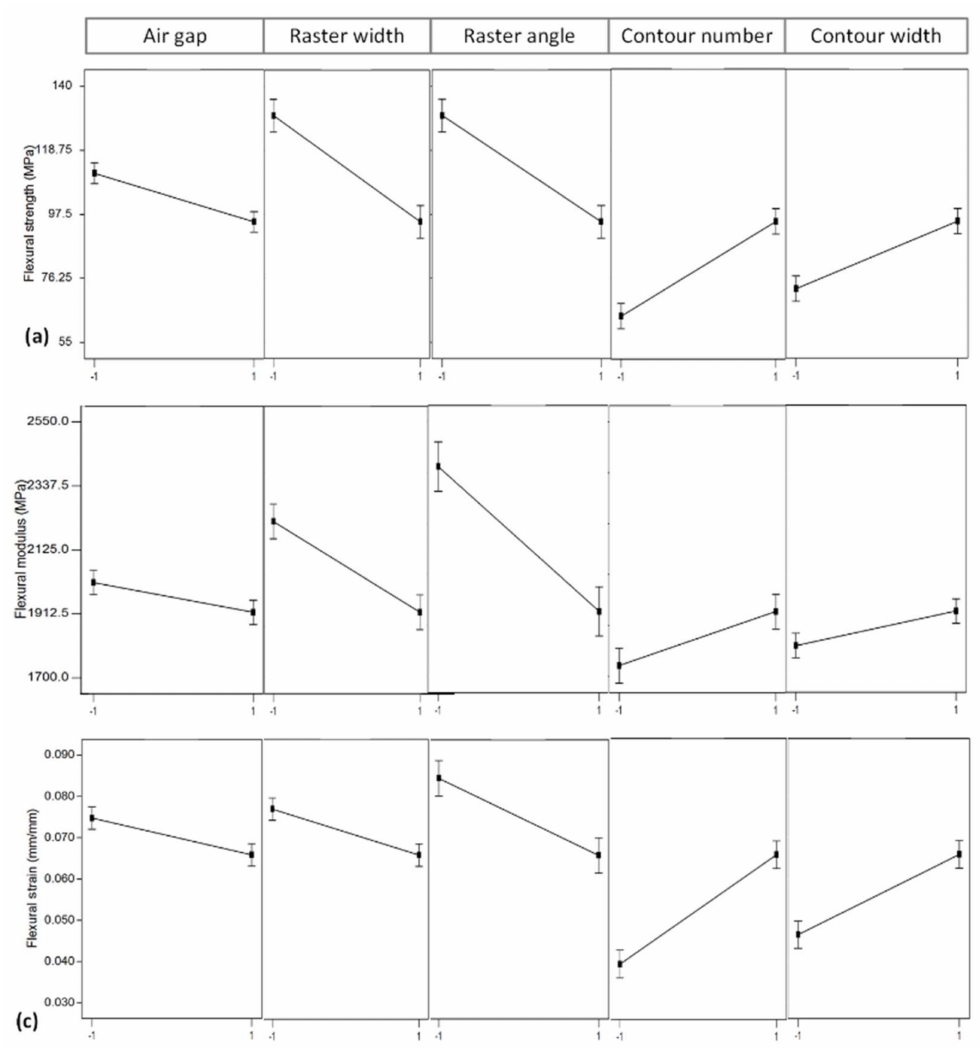
Figure 8. Plots showing main effects of process parameters on ( a ) flexural strength; ( b ) flexural modulus; and ( c ) flexural